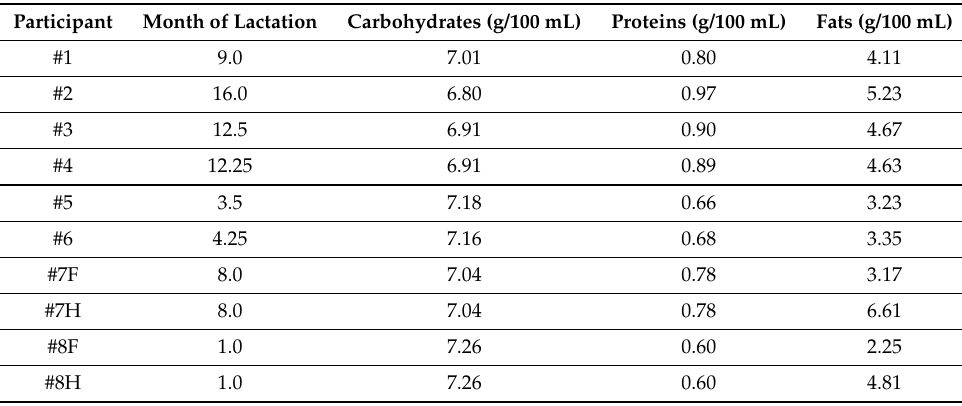
Table 4. Estimated Macronutrient